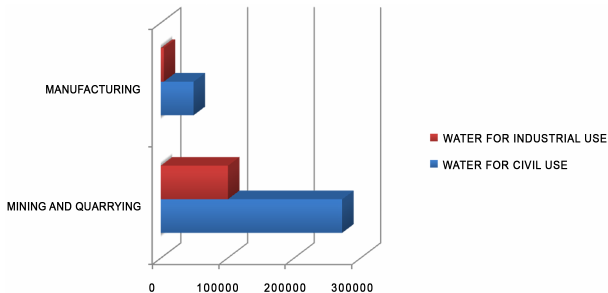
Figure 2. Water consumption for industrial and civil use for mining and quarrying and manufacturing sectors [10 6 m 3 ] (Source: AR- GAIP Potenza).